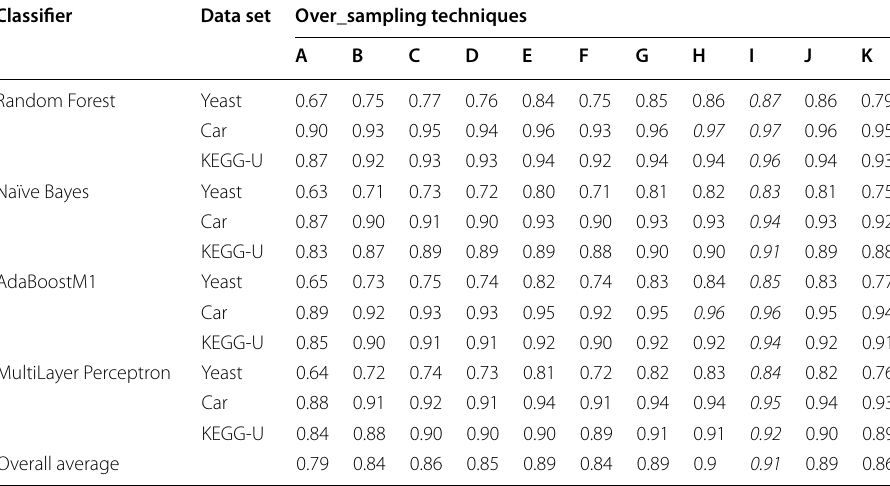
Italic values indicate highest result